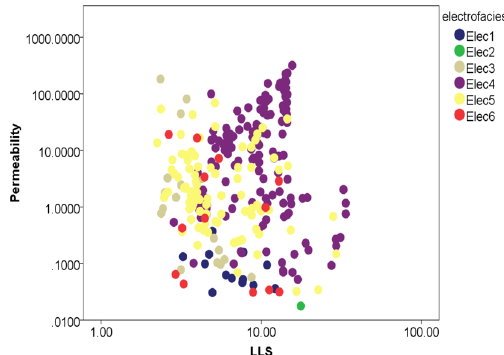
Fig. 15 LLS–K crossplot in electrofacies